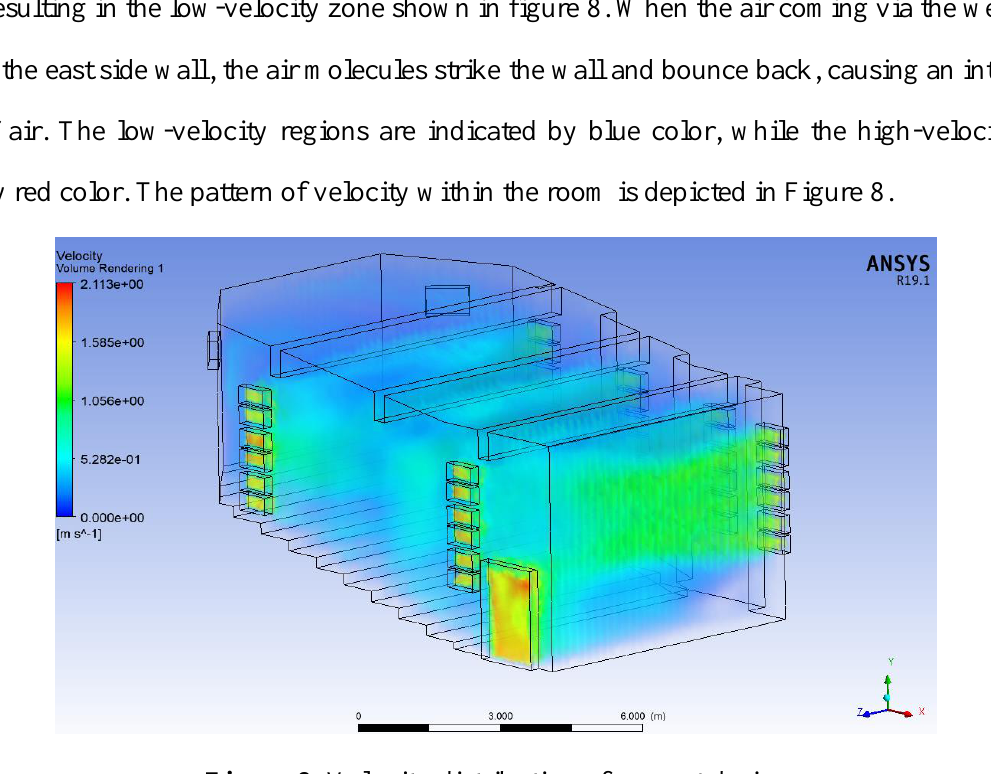
Figure 8. Velocity distribution of present